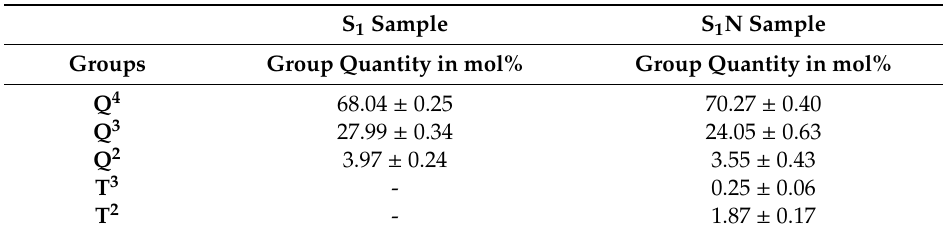
Table 1. Percentage of groups obtained by deconvolution (Gaussian fitting) of 29 Si NMR MAS spectra before and after the amino-functionalization